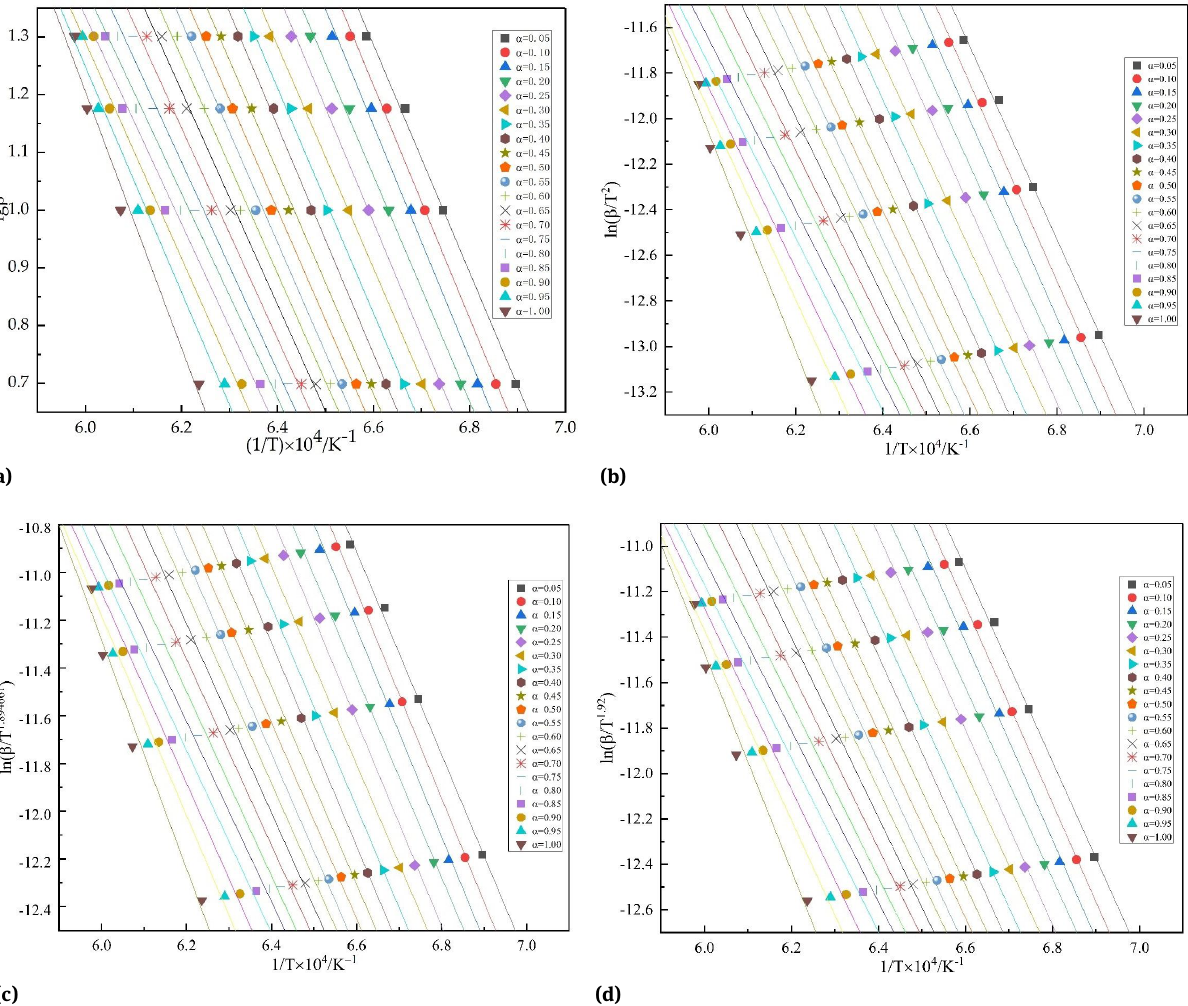
Figure 3: Linear fit of apparent activation energy of phosphate rock with particle size 48–75 µ m at different conversion degrees. (a): FWO; (b): KAS; (c): Tang; (d):